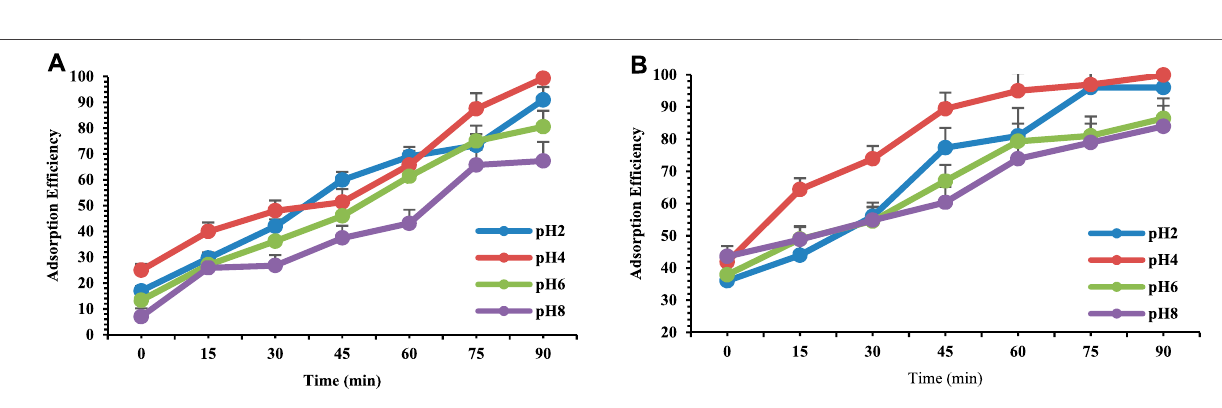
FIGURE 4 | Adsorption ef fi ciency of 10 ppm (A) Chromium and (B) Lead on 10 mg orange peel/selenium nanocomposite as a function of pH.